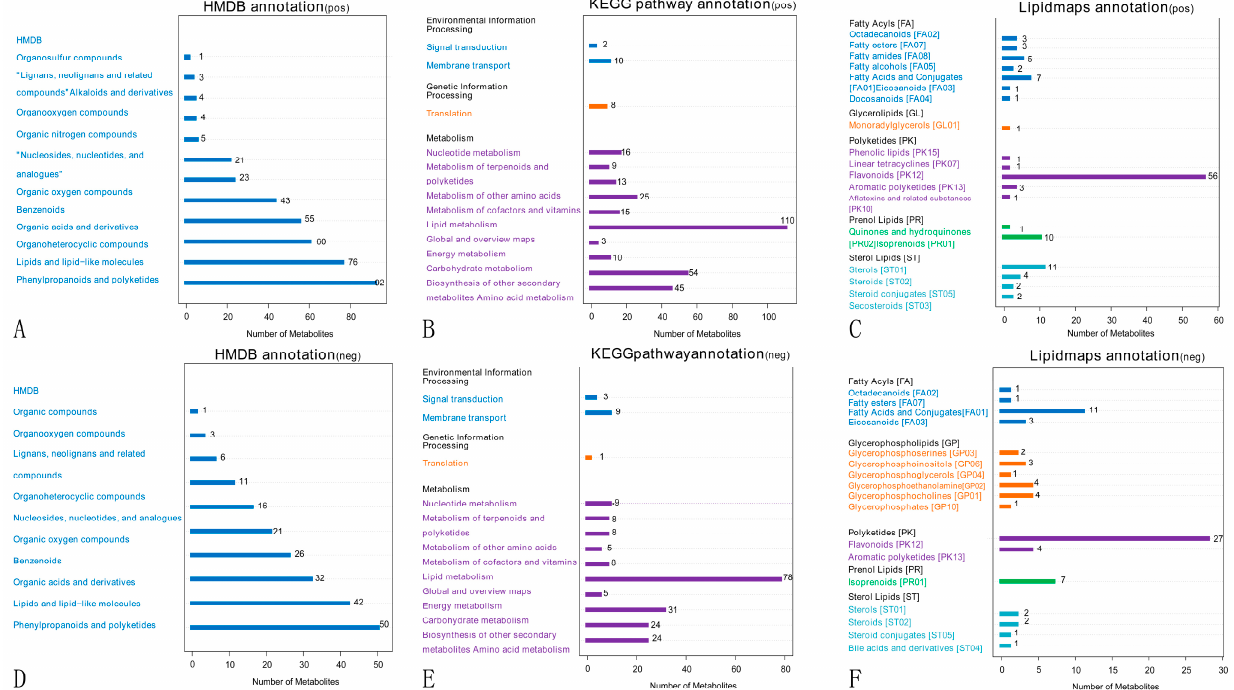
Figure 5. Annotated diagram of metabolite pathway and classification. Note: ( A , D ) Annotated HMDB taxonomic map of metabolites. ( B , E ) Annotated map of the KEGG pathway of metabolites. ( C , F ) Annotated map of LIPID MAPS classification of metabolites.